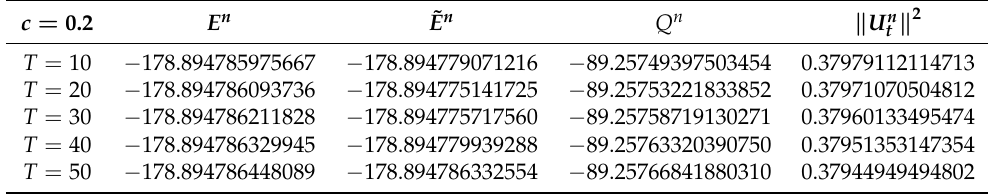
Table 3. Discrete energy E n and discrete quantities ˜ E n , Q n , and (cid:107) U n c = 0.2